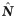
Average relative bias of the posterior mean of abundance (N^) from the Two-Step and the One-Step CMR model over a range of group-detection probabilities (pg) and individual-detection probability (pi).When pg was varied, pi was held constant at 0.7, and vice versa.